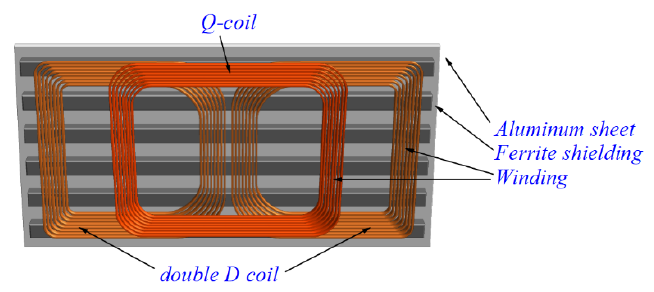
Figure 7. Double D&Q (DDQ) coupler configuration.